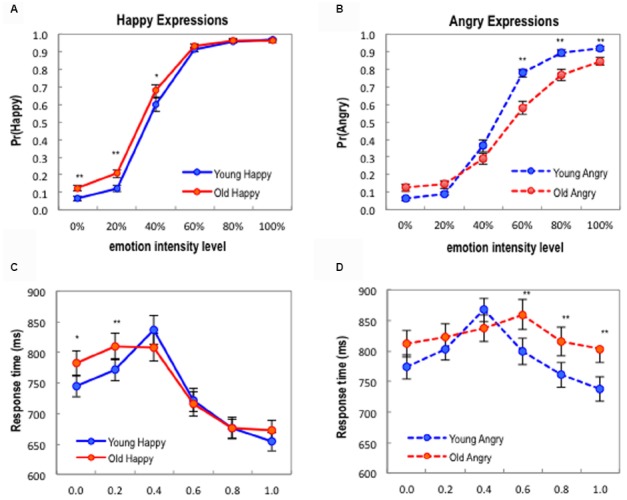
(A) Probabilities of happy decisions as a function of emotion intensity and facial age. (B) Probabilities of angry decisions as a function of emotion intensity and facial age. (C) Response times of happy decisions. (D) Response times of angry decisions. Error bars denote the standard error of the mean. *p < 0.05; **p < 0.01 (Bonferroni corrections applied).